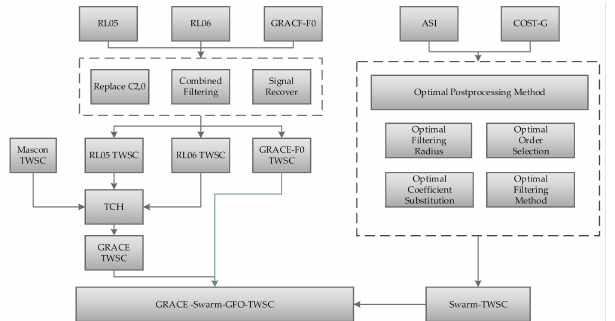
Figure 6. The processing flow of this research. Firstly, get the GRACE-TWSC and GRACE-FO-TWSC, secondly, based on GRACE-TWSC, compared different results from different Swarm models and different postprocessing methods, get the Optimal Swarm-TWSC, thirdly, combined GRACE-TWSC, Swarm-TWSC and GRACE-FO-TWSC, get the